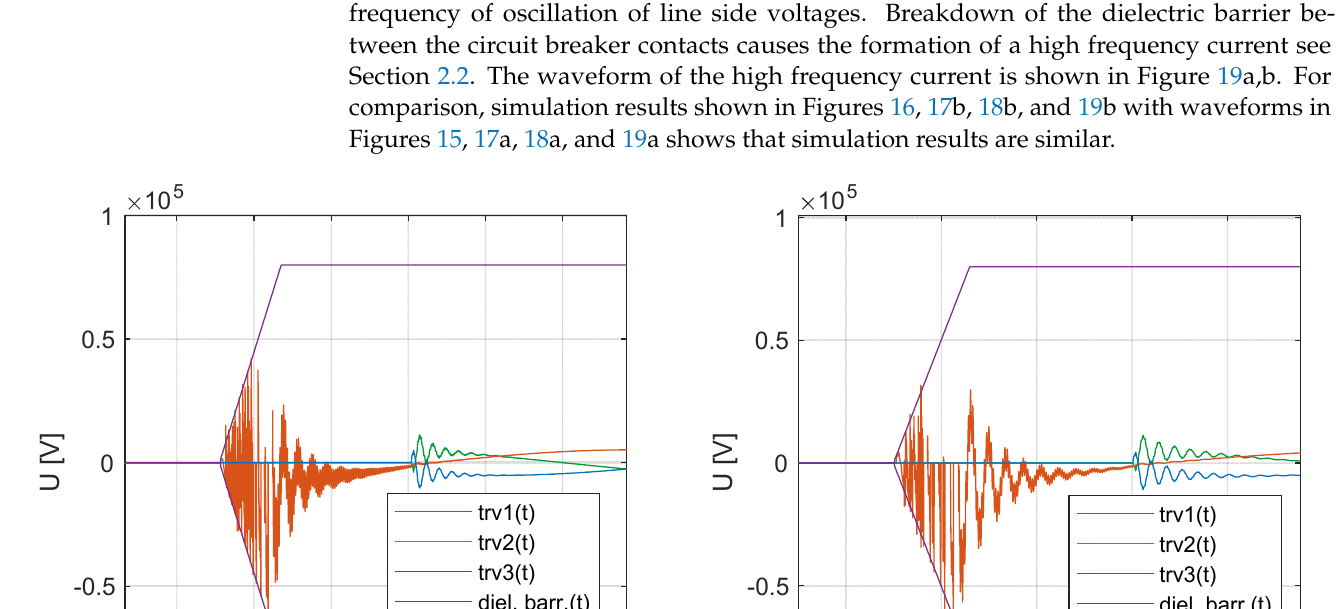
0.18 0.182 0.184 0.186 0.188 0.19